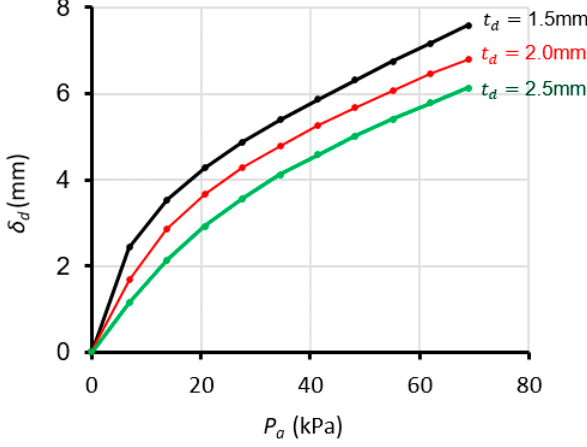
Figure 4. Displacement values ( δ d ) at varying applied pressures ( P a ) for di ff erent thicknesses ( t d ) Figure 4. Displacement values (𝛿 (cid:3031) ) at varying applied pressures (𝑃 (cid:3028) ) for different thicknesses (𝑡 (cid:3031) ) . Figure 4. Displacement values (𝛿 (cid:3031) ) at varying applied pressures (𝑃 (cid:3028) ) for different thicknesses (𝑡 (cid:3031) ) .